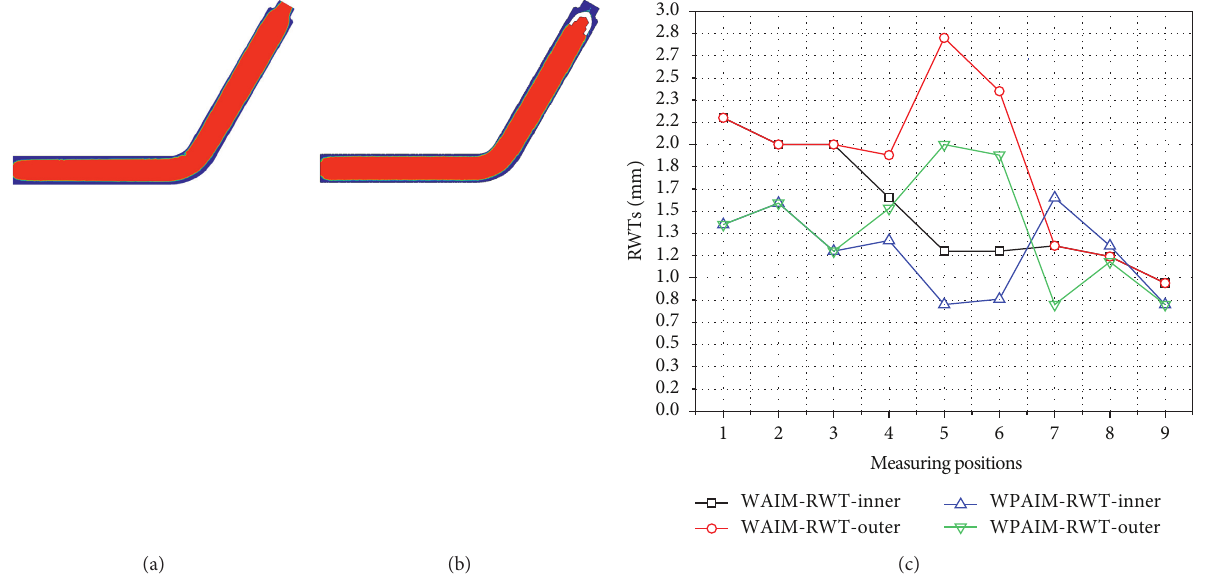
Figure 3: Comparison of penetration interfaces and RWTs between WAIM and W-PAIM pipe: (a) penetration interface of WAIM pipe, (b) penetration interface of W-PAIM pipe, and (c)